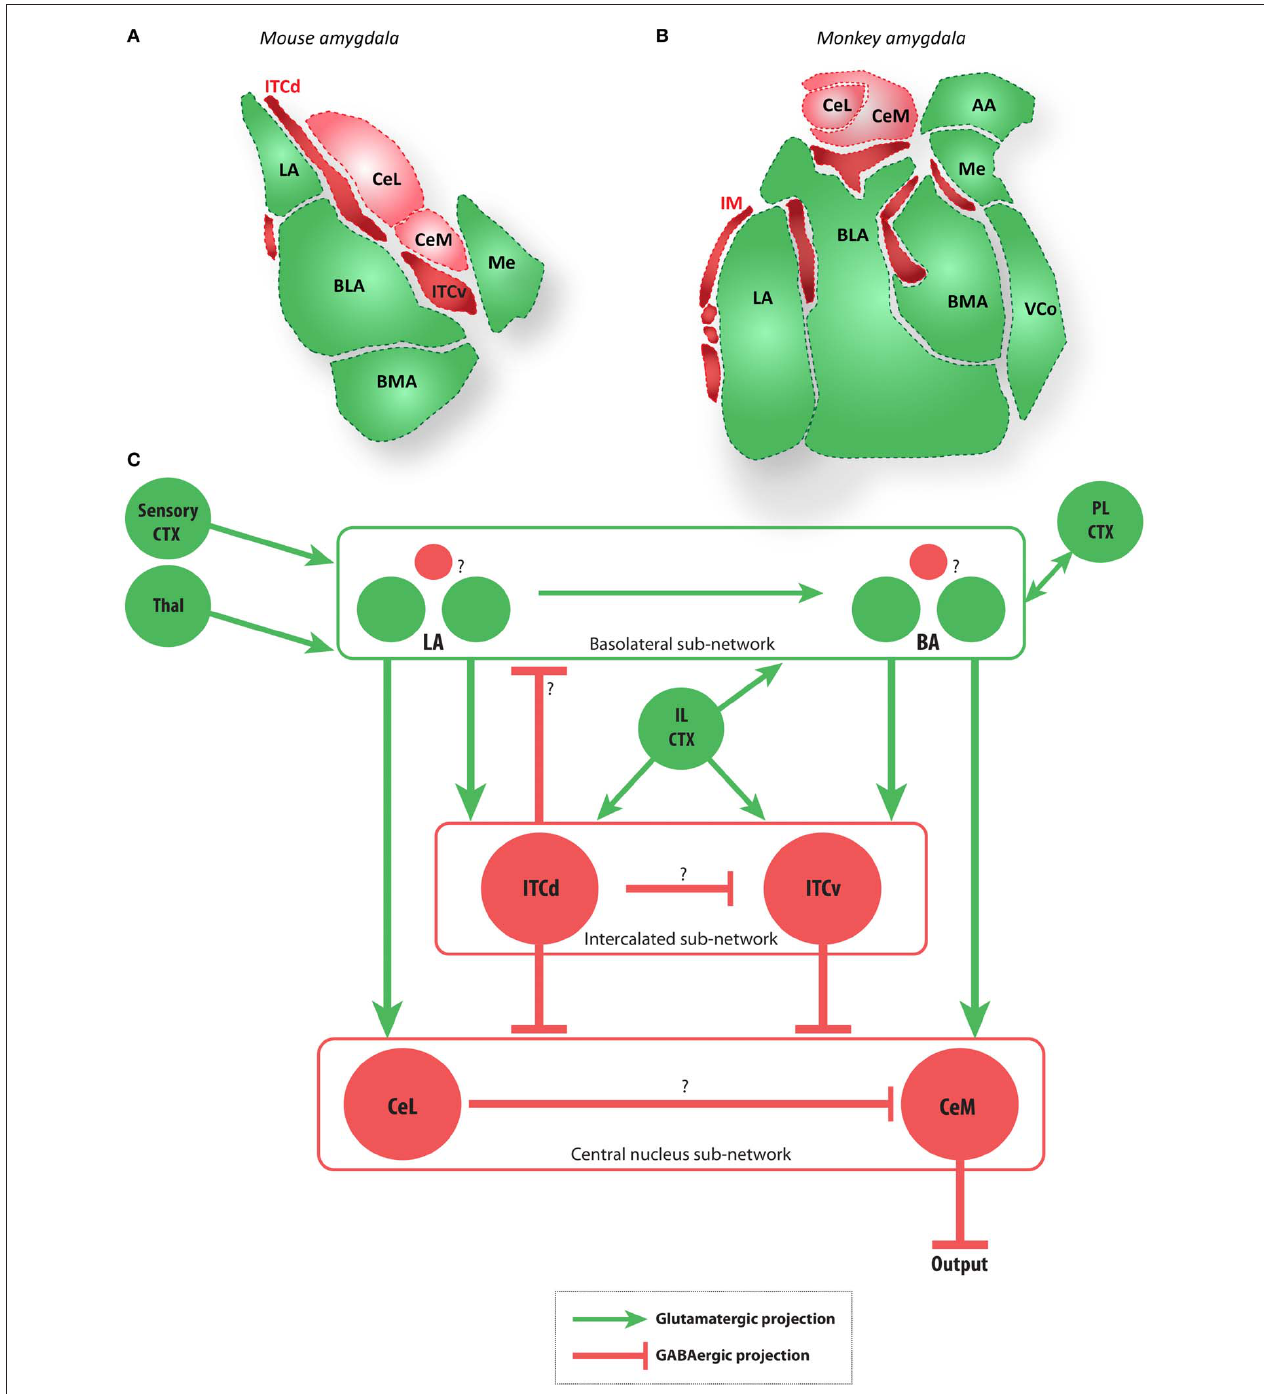
GABAergic intercalated sub-network (ITCd and ITCv). The basolateral sub-network receives information about CS and US via projections from sensory cortices (CTX) and thalamus (Thal). In rodents, cortical regions IL and PL project to the intercalated and basolateral sub-networks, respectively. The CeM is a key output node of the network. Question marks indicate local microcircuit details that remain to be fully characterized experimentally. Red circles and lines represent inhibitory cell groups and connections, and green circles and lines represent excitatory cell groups and